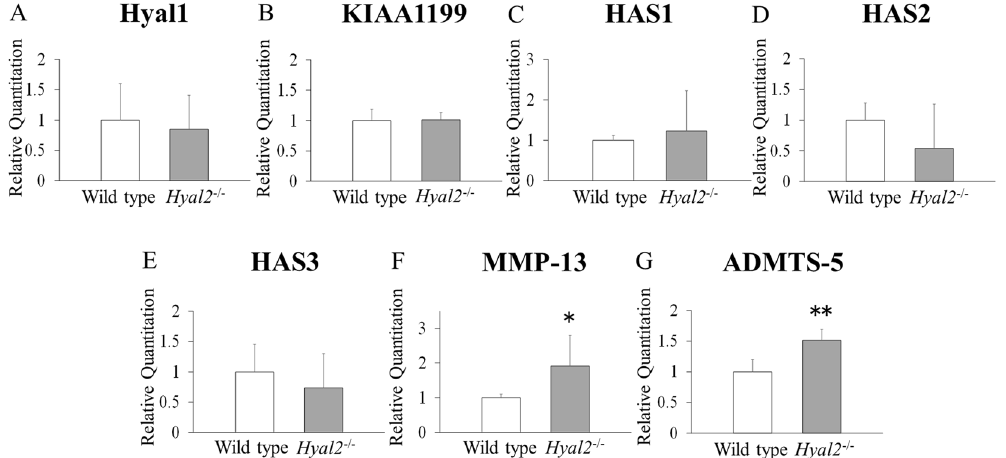
Figure 3. mRNA expression levels of hyaluronan-related molecules and proteolytic enzyme of extracellular matrix. mRNA expression of Hyal1( A ), KIAA1199( B ), HAS1( C ), HAS2( D ), HAS3( E ), MMP-13( F ), ADAMTS- 5( G ) in articular cartilage from 9-month-old male Hyal2 − / − and WT mice as determined by real-time PCR amplification (n = 6, respectively). The data presented are the average ± S.D of relative mRNA expression values standardized by Gapdh mRNA expression. * P < 0.05, ** P <